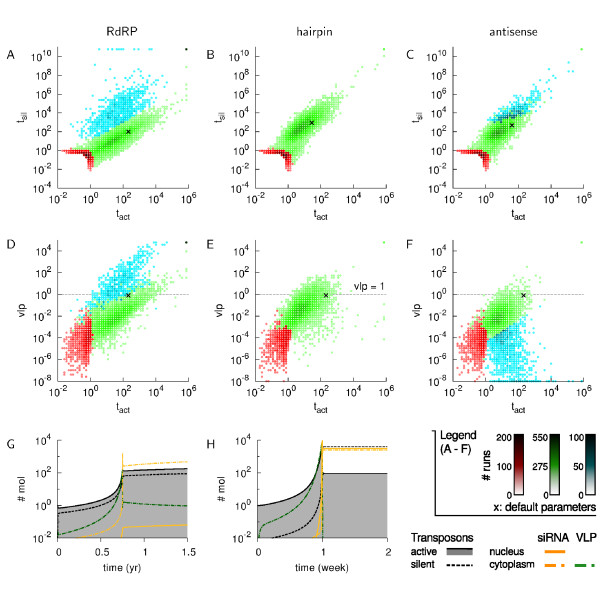
Transposon activity of 10000 simulations at t = 2 years. A, B, C. Two-dimensional histograms of active (tact) against silenced (tsil) transposons. D, E, F. Two-dimensional histograms of active transposons against cytoplasmic virus-like particles (vlp). The cross (×) indicates the result of a run with default parameters (Table 1). The horizontal line indicates the condition V LP <1.0. A, D. RdRP model, the simulations are categorized in three clusters. Red indicates the "no invasion" cluster, green the "controlled" cluster and blue the "out of control" simulations. B, E. Hairpin model, two cluster are distinguished: the red "no invasion" and green "controlled" cluster. C, F. Antisense model, three clusters of simulations are present: red is "no invasion", green "controlled", and blue "low VLP". Note the log scale of both axes in all figures. G. Time plot of a single simulation using the default parameter values of the RdRP model (green cluster). H. Time plot of a single simulation from the antisense model (blue cluster).